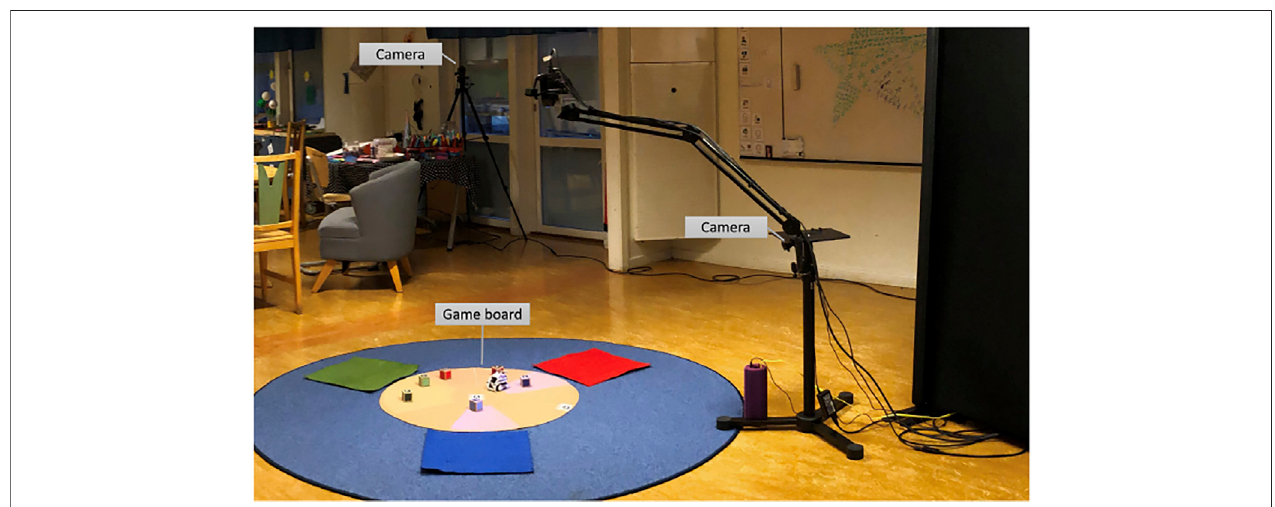
FIGURE 1 | Experimental set-up used during the study. Each child was seated on one of the colourful patches around the game board. The sessions were fi lmed from both cameras.